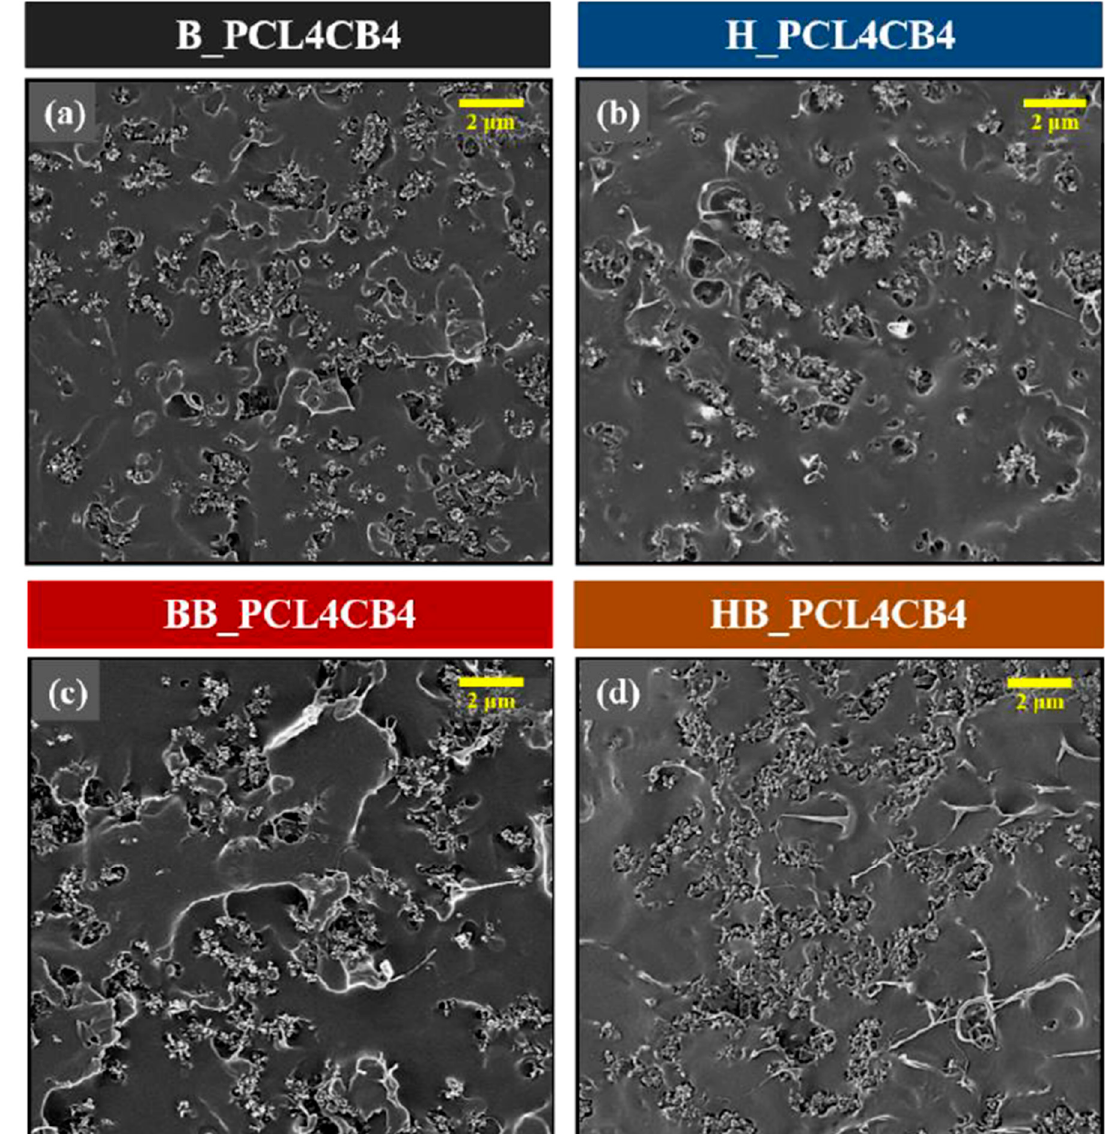
Figure 3. SEM images of the fractured surface of the ternary composite (PCL4CB4) depending on the mixing method: ( a ) B_PCL4CB4, ( b ) H_PCL4CB4, ( c ) BB_PCL4CB4, and ( d )